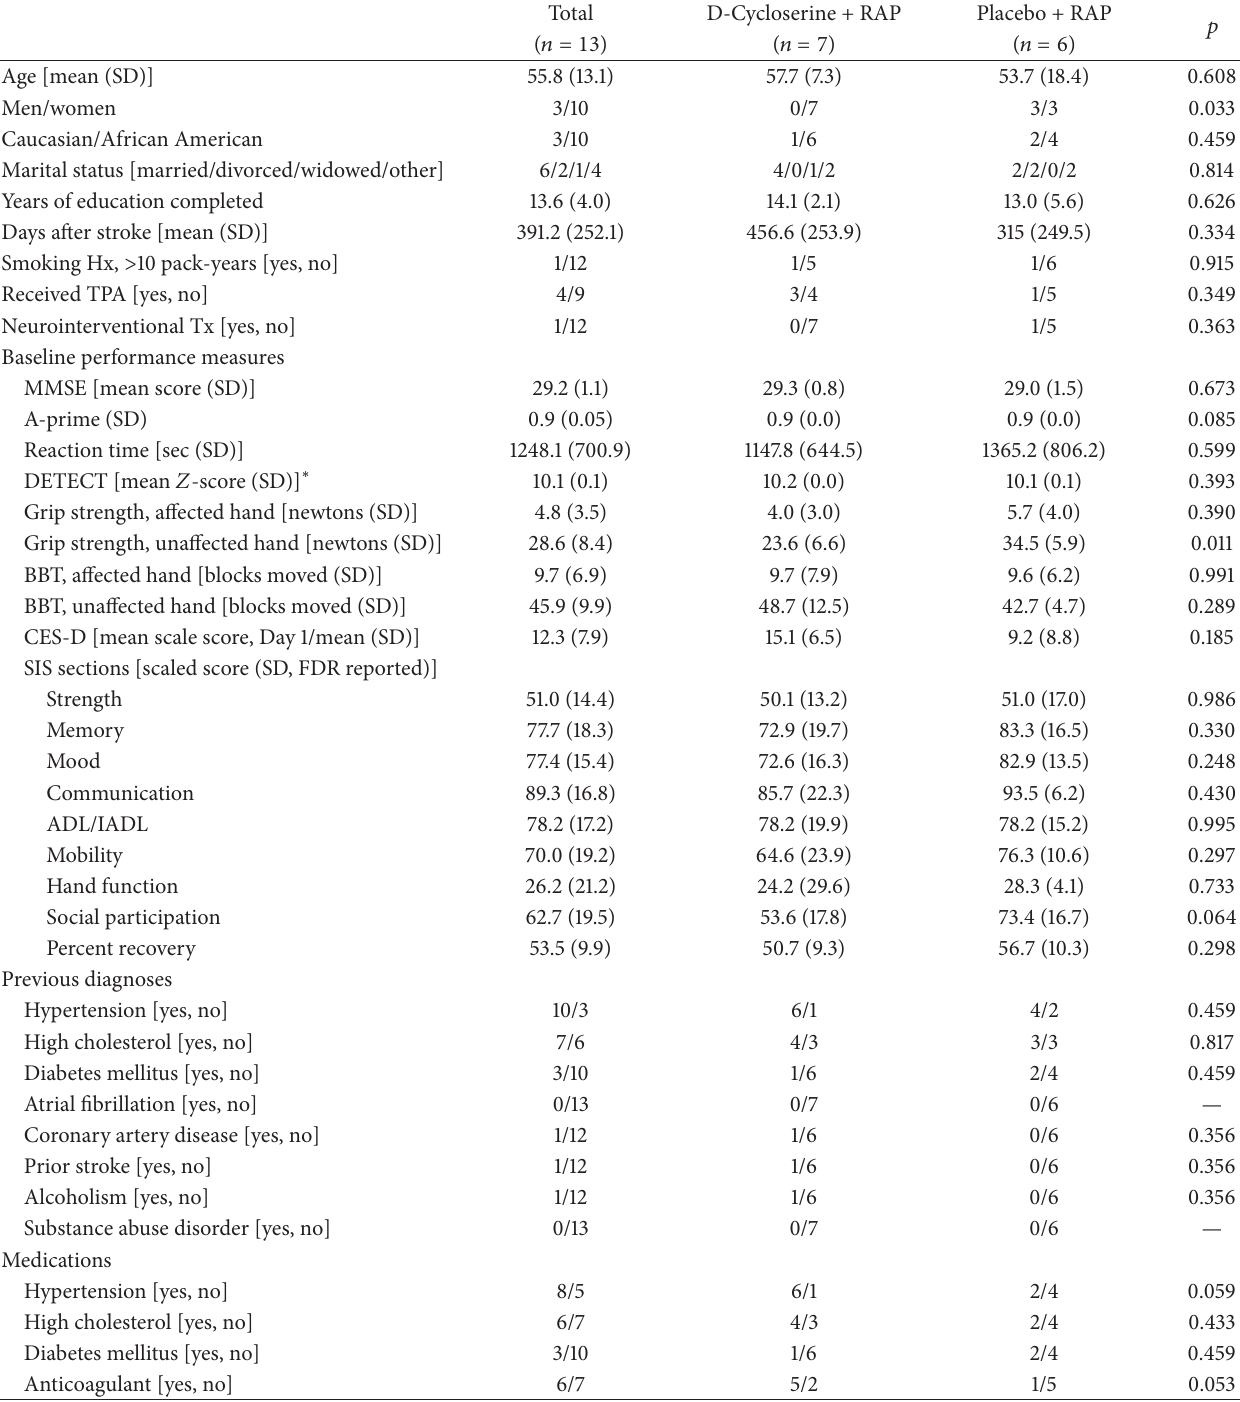
Table 1: Characteristics and baseline assessment of study participants as a whole and by group ( ∗ note that mean DETECT 𝑍 -scores were computed for 𝑛 = 6 and 𝑛 = 5 for DCS + RAP and placebo + RAP groups, resp., due to missing values resulting from technical issues with the instrument). Hx: history; Tx: therapy; SIS: Stroke Impact Scale; TPA: tissue plasminogen activator.